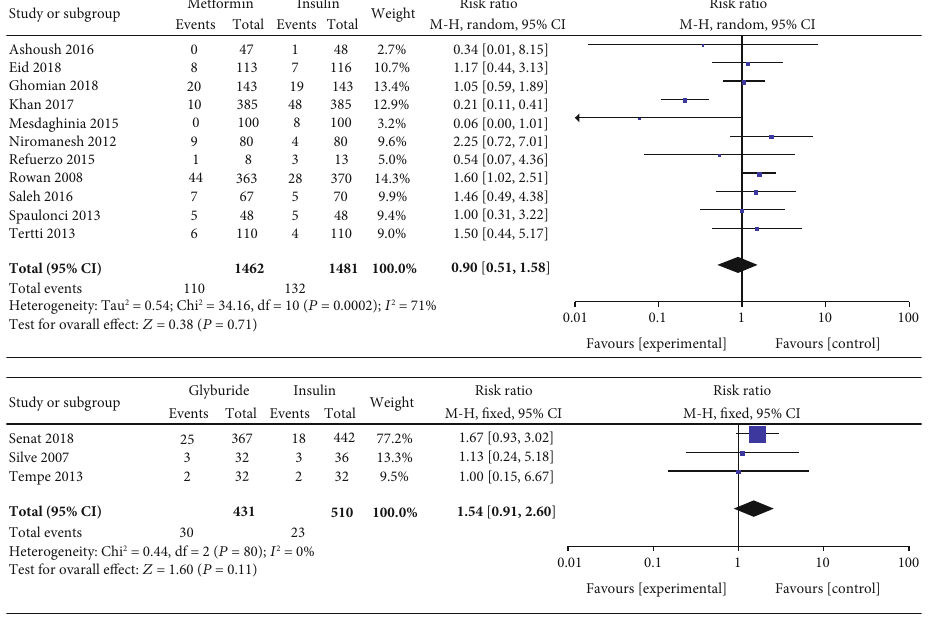
Figure 10: Preterm